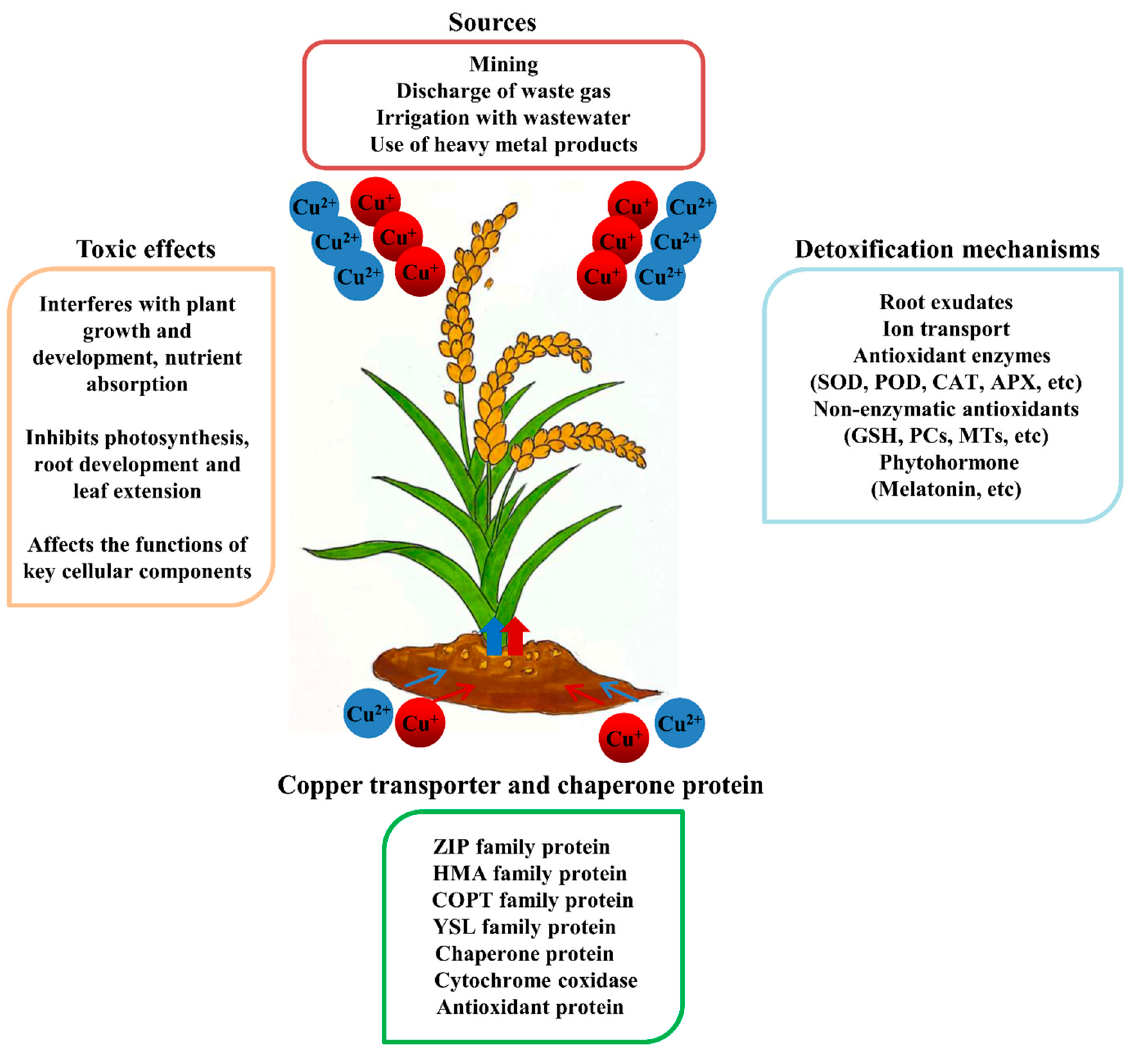
Figure 2. Responses and defense mechanisms of plants to copper stress.